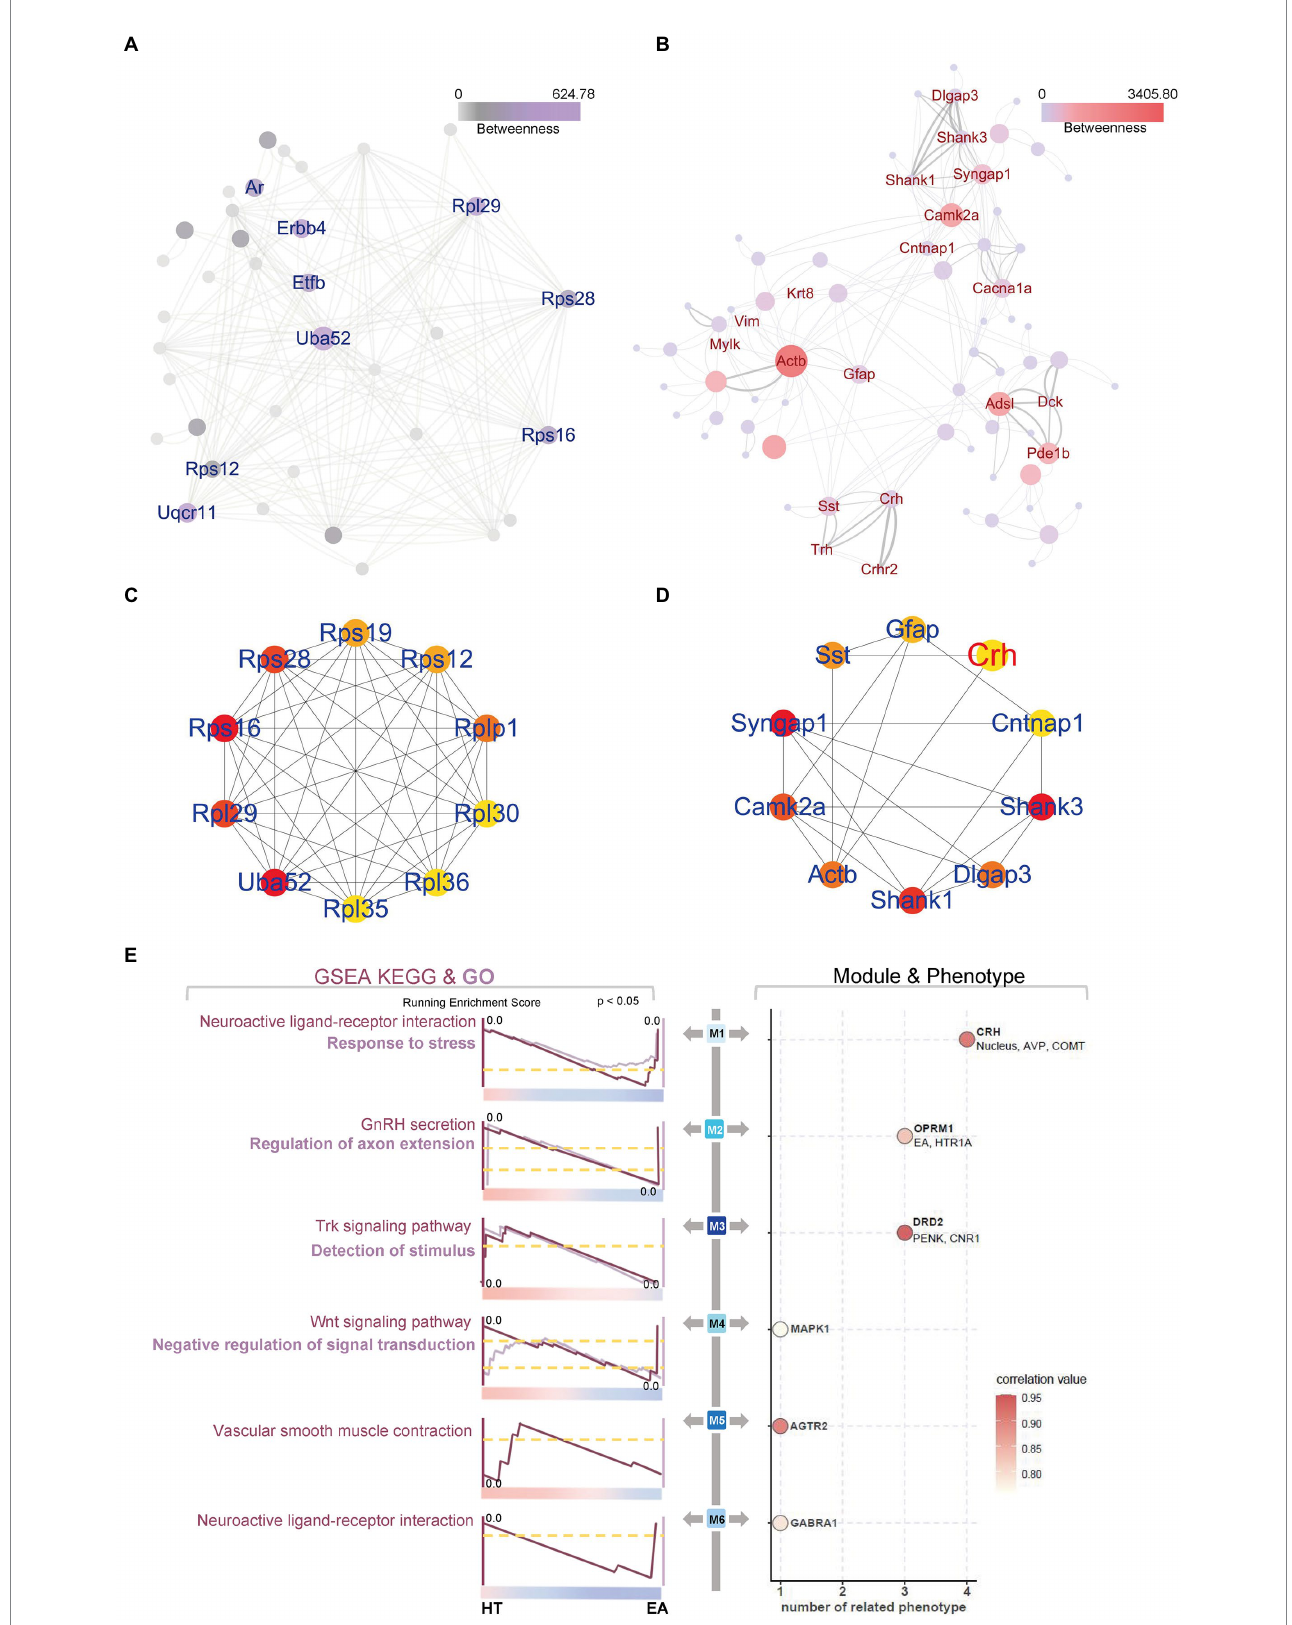
FIGURE 4 PPI networks and WGCNA further explored EA’s effect on the PVN. (A,B) PPI and (C,D) Hub genes of DEGs in the CEA and PVN were identified using online STRING tools and the Cytoscape App CytoHubba . (E) WGCNA and GSEA identified six different modules with specific functions. The top enriched GSEA terms are shown, and the color bar indicates the correlation value. The line thickness and circle size in (B) indicated the combined score and betweenness auto-calculated by the Cytoscape software, representing the connectivity between two